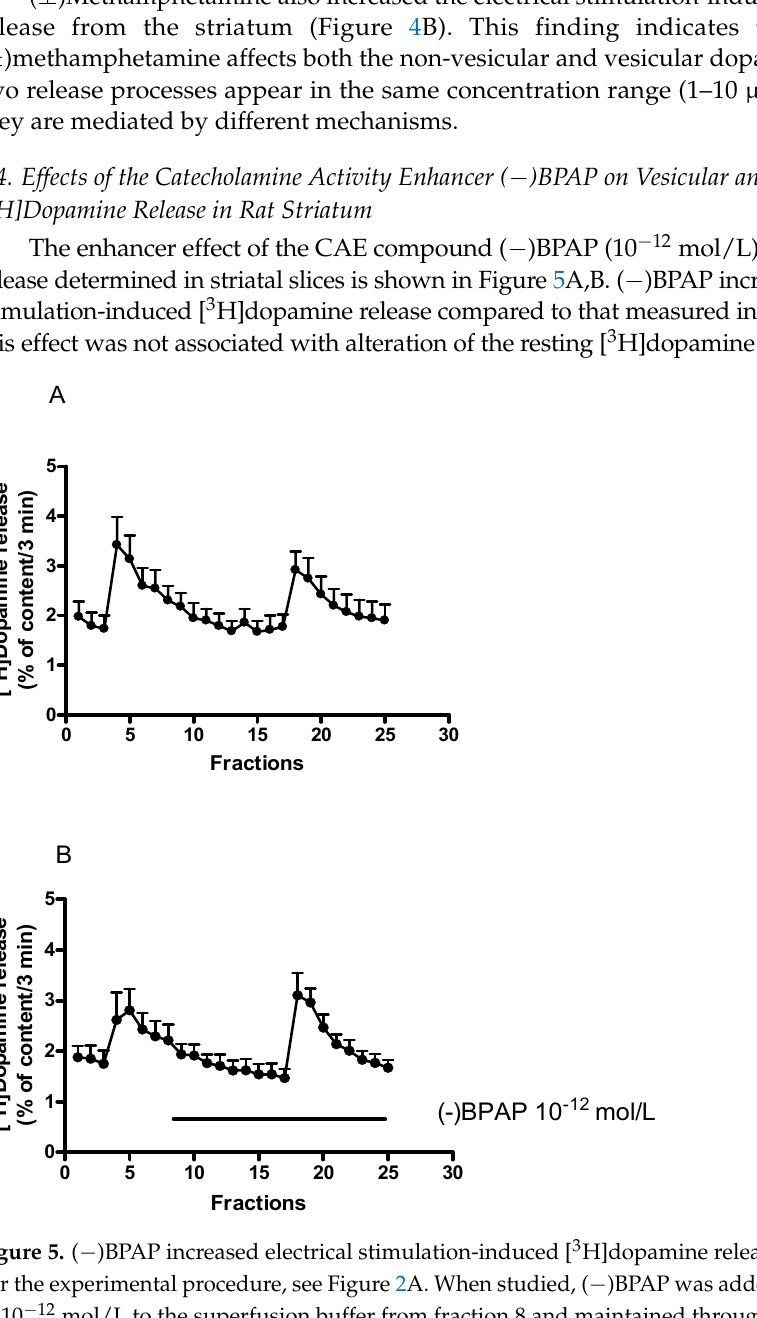
mean ± S.E.M., n = 7-6.